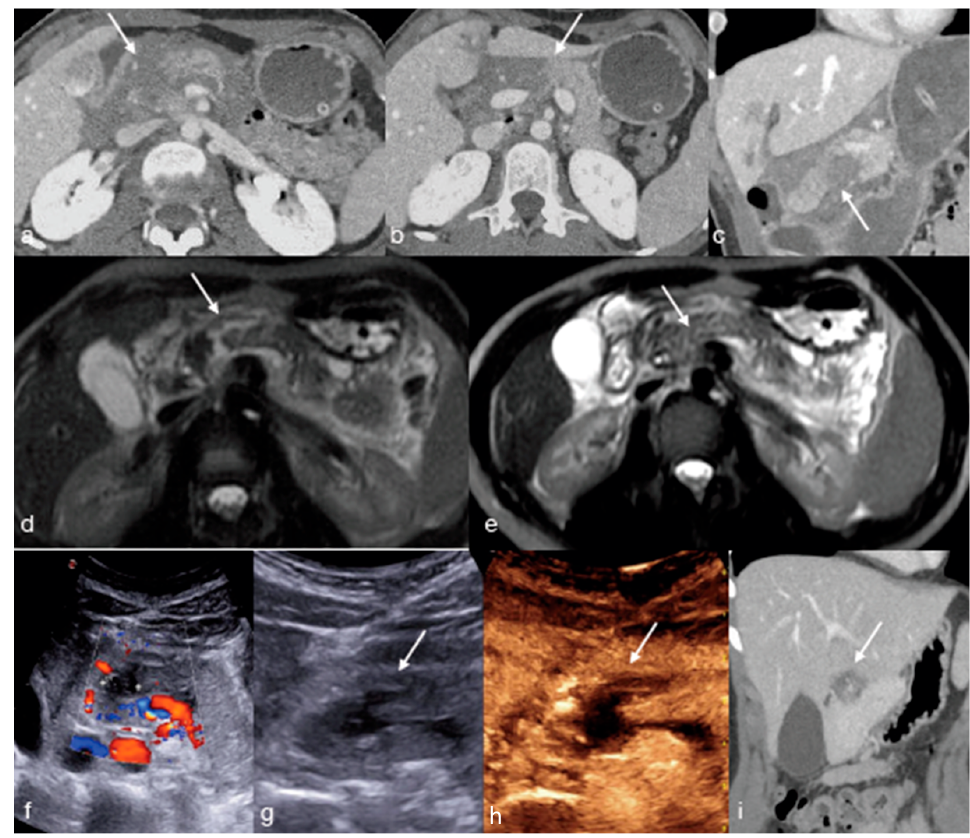
Figure 10. A twenty-two-year-old female who fell down the stairs: ( a – c ) enhanced CT in axial ( a , b ) and coronal oblique view ( c ) showing a pancreatic laceration ( a – c, arrows ). The day after, a MRI was performed to evaluate the main duct involvement (( d , e ) arrows) and a lesion was excluded (AAST II), so the patient underwent a subsequent follow-up at 5 days by US-Doppler ( f ) and CEUS (( g,h ) arrows), and at 20 days by CT (( i ) coronal oblique view, arrow).